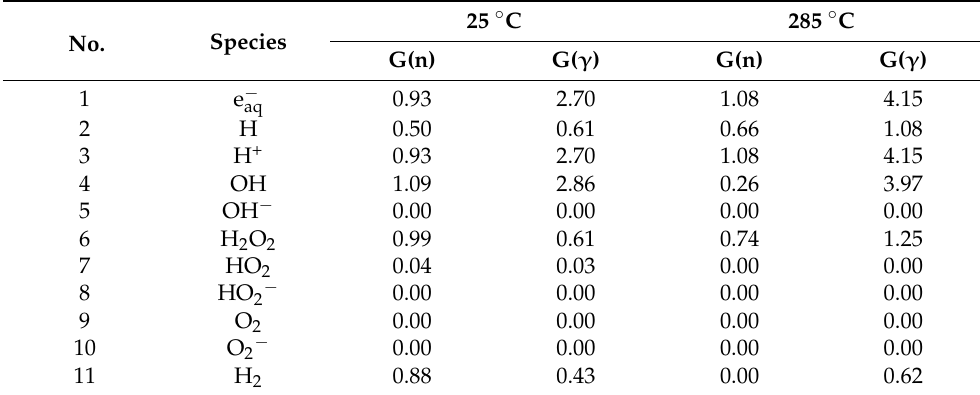
Table 9. G-values for primary radiolytic species at two temperatures used in the modeling of primary coolant in BWRs [215–252,255] (after Burns and Moore [44]). 25 ◦ C 285 ◦ C No. Species G(n) G( γ ) G(n) G( γ ) 1 e − aq 0.93 2.70 1.08 4.15 2 H 0.50 0.61 0.66 1.08 3 H + 0.93 2.70 4.15 OH 1.09 OH − 0.00 0.00 0.00 0.00 H 2 O 2 0.99 HO 2 0.04 HO 2 − 0.00 O 2